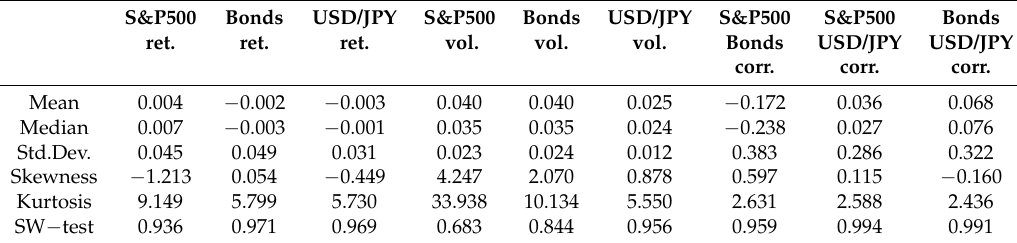
Table 5. Descriptive Statistics for monthly data, sample size is n 1 = 469 months from 01/1970 to 02/2010; SW is short for Shapiro–Wilk. The first 3 columns refer to returns, the middle 3 columns to realized volatilities, and the last 3 columns to correlations.